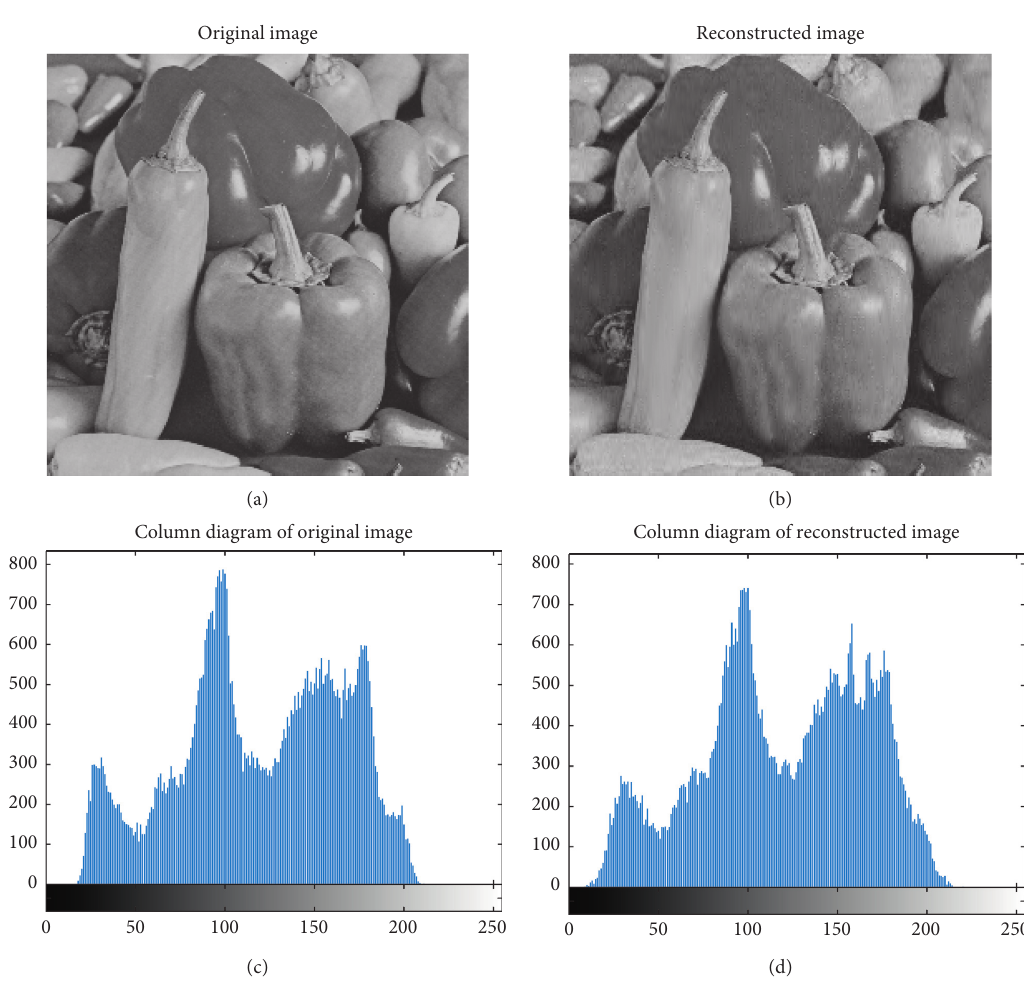
Figure 7: Histogram of original and reconstructed image: (a) original image, (b) reconstructed image, (c) histogram of original image, and (d) histogram of reconstructed image. Table 3: Structural similarity between original image and reconstructed